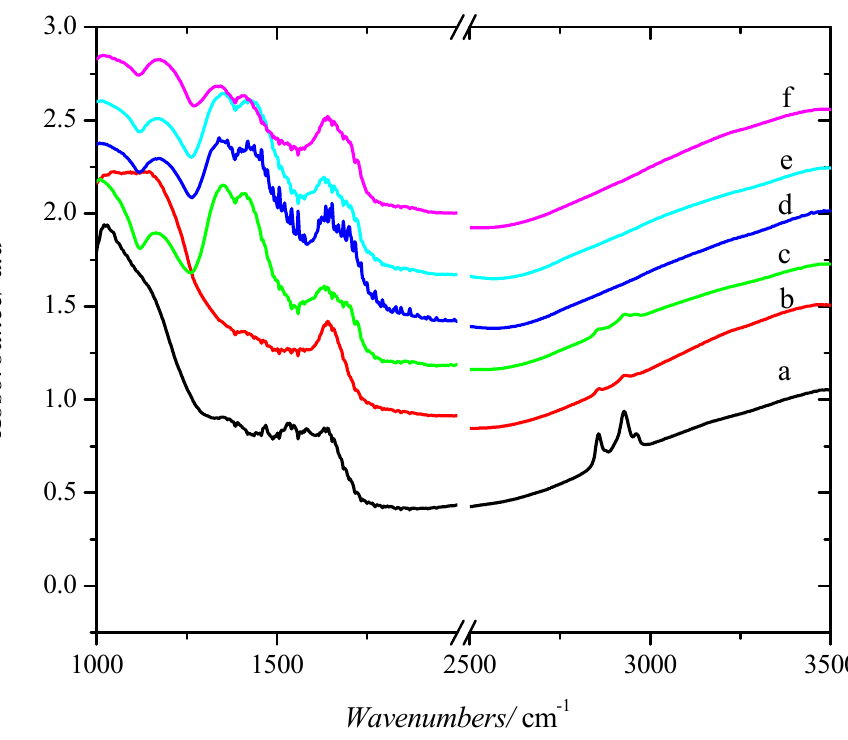
Figure 4. FTIR spectra of ( a ) DDA/ γ -Al 2 O 3 ; ( b ) Au-DDA/ γ -Al 2 O 3 ; ( c ) Au-DDA/ γ -Al 2 O 3 (O 3 6 h); ( d ) Au-DDA/ γ -Al 2 O 3 (O 3 7 h); ( e ) Au-DDA/ γ -Al 2 O 3 (O 3 8 h); and ( f ) Au-DDA/ γ -Al 2 O 3 (O 3 10 h).